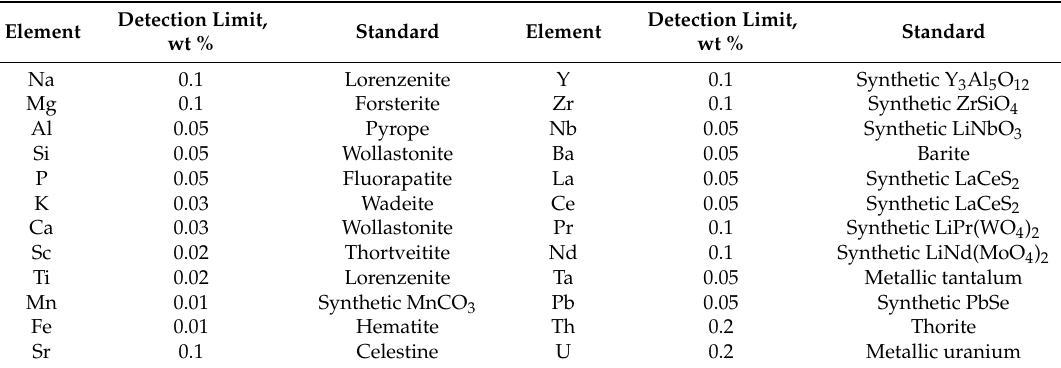
Table 1. Parameters of electron probe microanalyzer (EPMA)